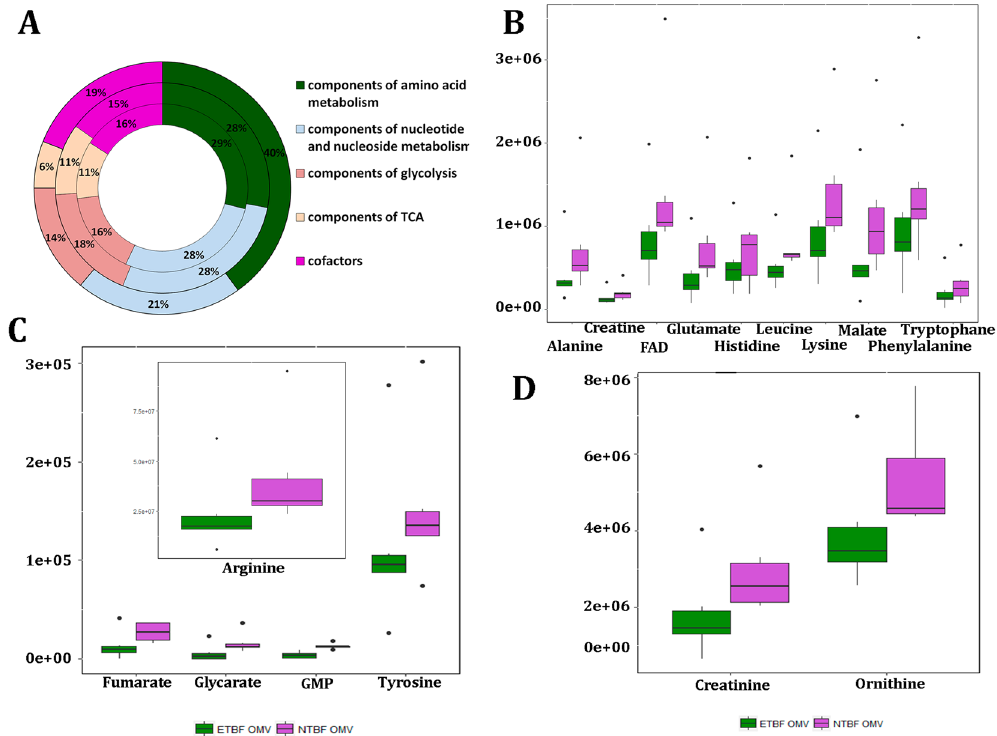
Figure 5. Qualitative and quantitative analyses of ETBF and NTBF metabolites identified in B. fragilis cells and OMVs. ( A ) Qualitative analysis of metabolites identified in OMVs (external histogram), ETBF cells (middle histogram) and NTBF cells (internal histogram). Metabolites involved in certain metabolic pathways are represented as percentages of the total number of identified in ETBF OMVs/cells and NTBF OMVs/cells metabolites. ( B – D) The Box plots show the quantitative differences of the amounts of several metabolites identified in ETBF and NTBF OMVs.